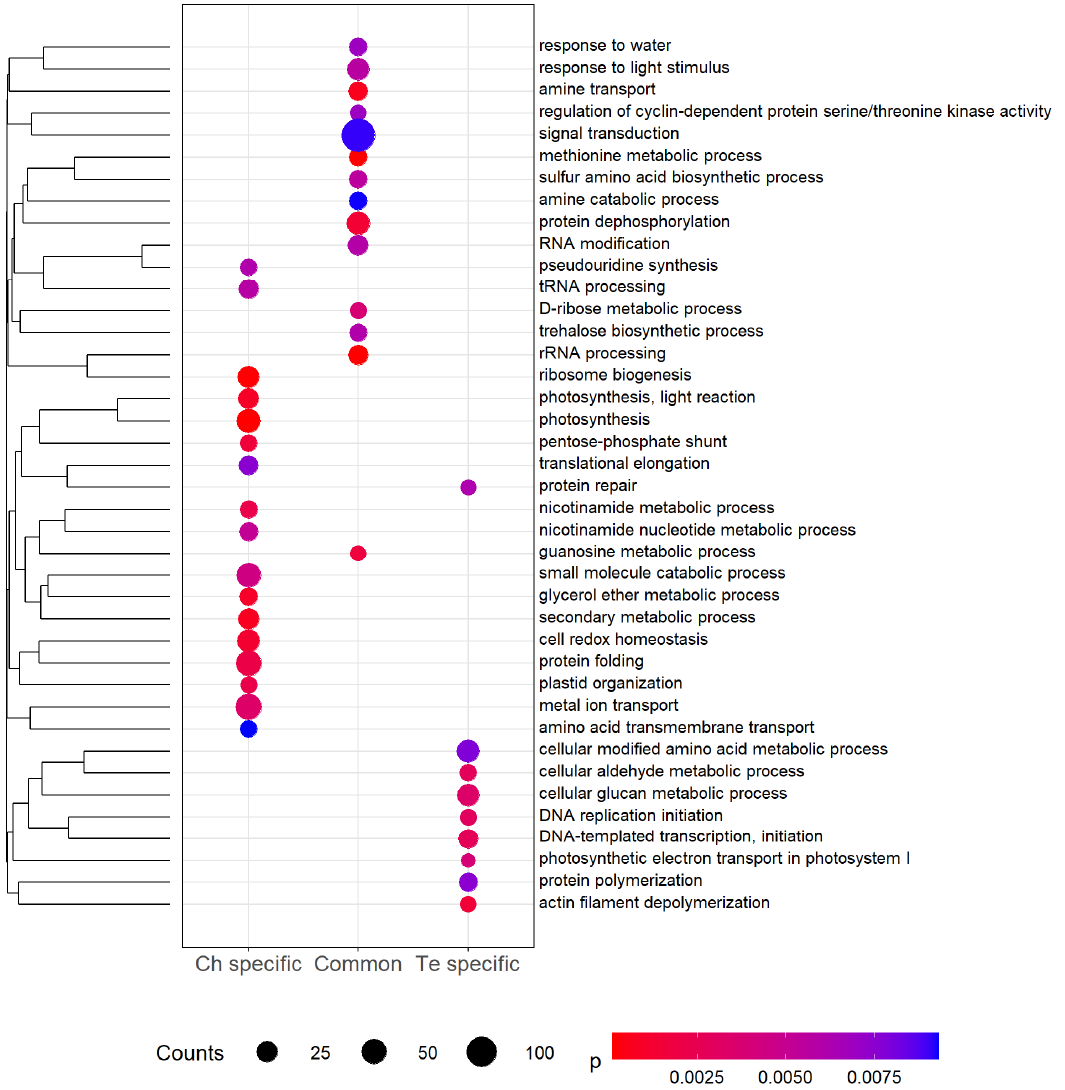
Figure 5. Significantly ( p -value < 0.01) enriched Gene Ontology (GO) biological process terms among differentially expressed genes (DEGs) specific to Ch, Te, and common to the two genotypes. Counts indicate the number of DEGs annotated with each GO term, and dots are colored by p -value. GO terms are clustered using hierarchical clustering (complete linkage) using GOGO semantic similarity [38] between terms.